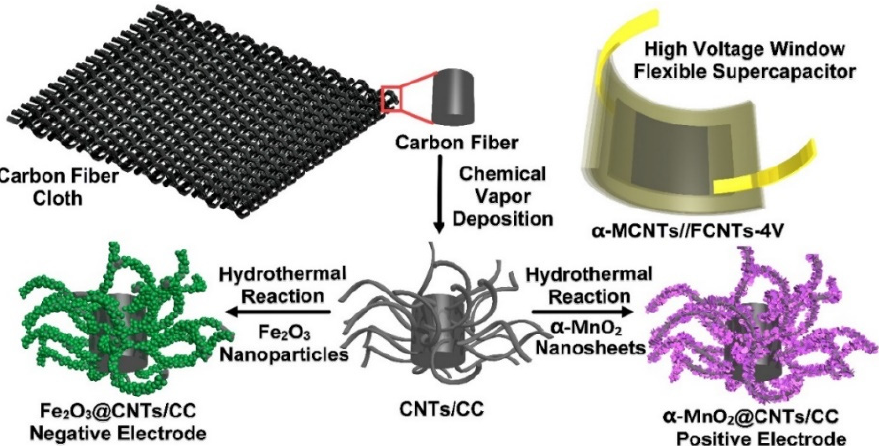
Figure 1. Schematic illustration of the fabrication of the electrodes and flexible supercapacitor with a large voltage window comprising the α -MnO 2 @CNTs/CC positive electrode and Fe 2 O 3 @CNTs/CC negative